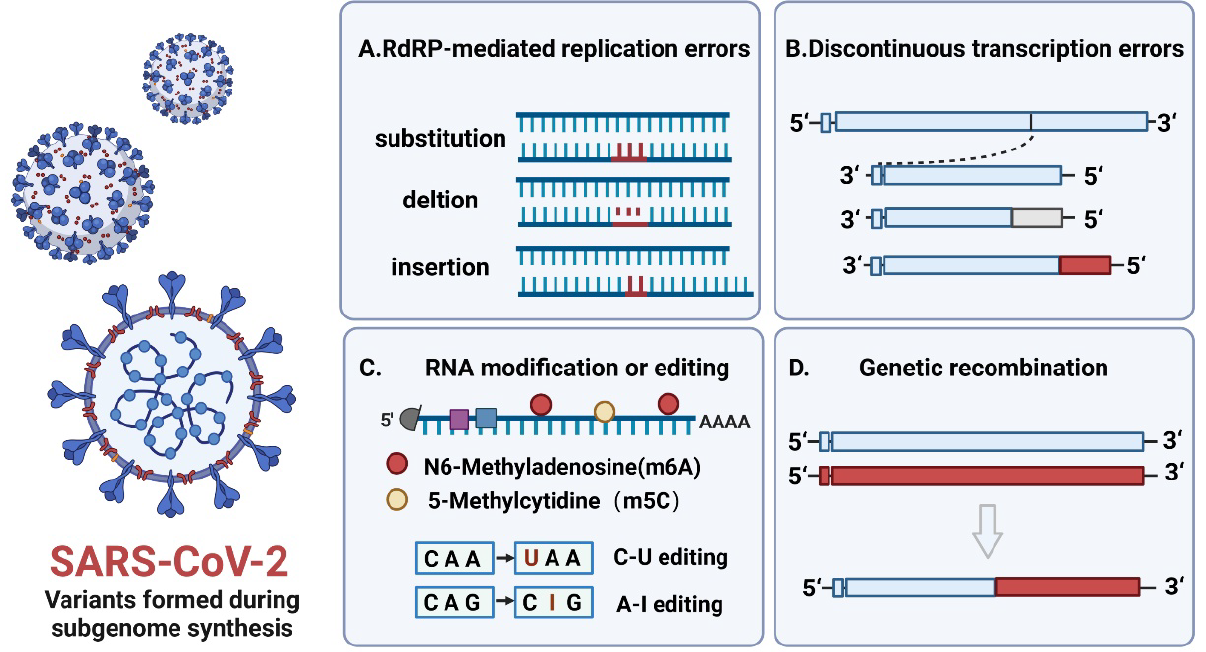
Figure 2. Potential mechanism of SARS-CoV-2 variants caused by sgRNAs during replication. ( A ) The sgRNAs sequence errors occur due to RdRP-mediated base substitution, base deletions, or base insertions. ( B ) Discontinuous transcription leads to defective sgRNAs formation, including loss of partial viral sequences (gray part) or addition of nonviral sequences (red part). ( C ) SgRNA replica- tion properties alter because of host-mediated RNA modification or editing. ( D ) Genetic recombi- nation may occur among different subgenomes to form new subgenomic types. The blue and red parts represent different subgenomic RNA, respectively. Image created with BioRender. (https://bi- orender.com/ (accessed on 8 August